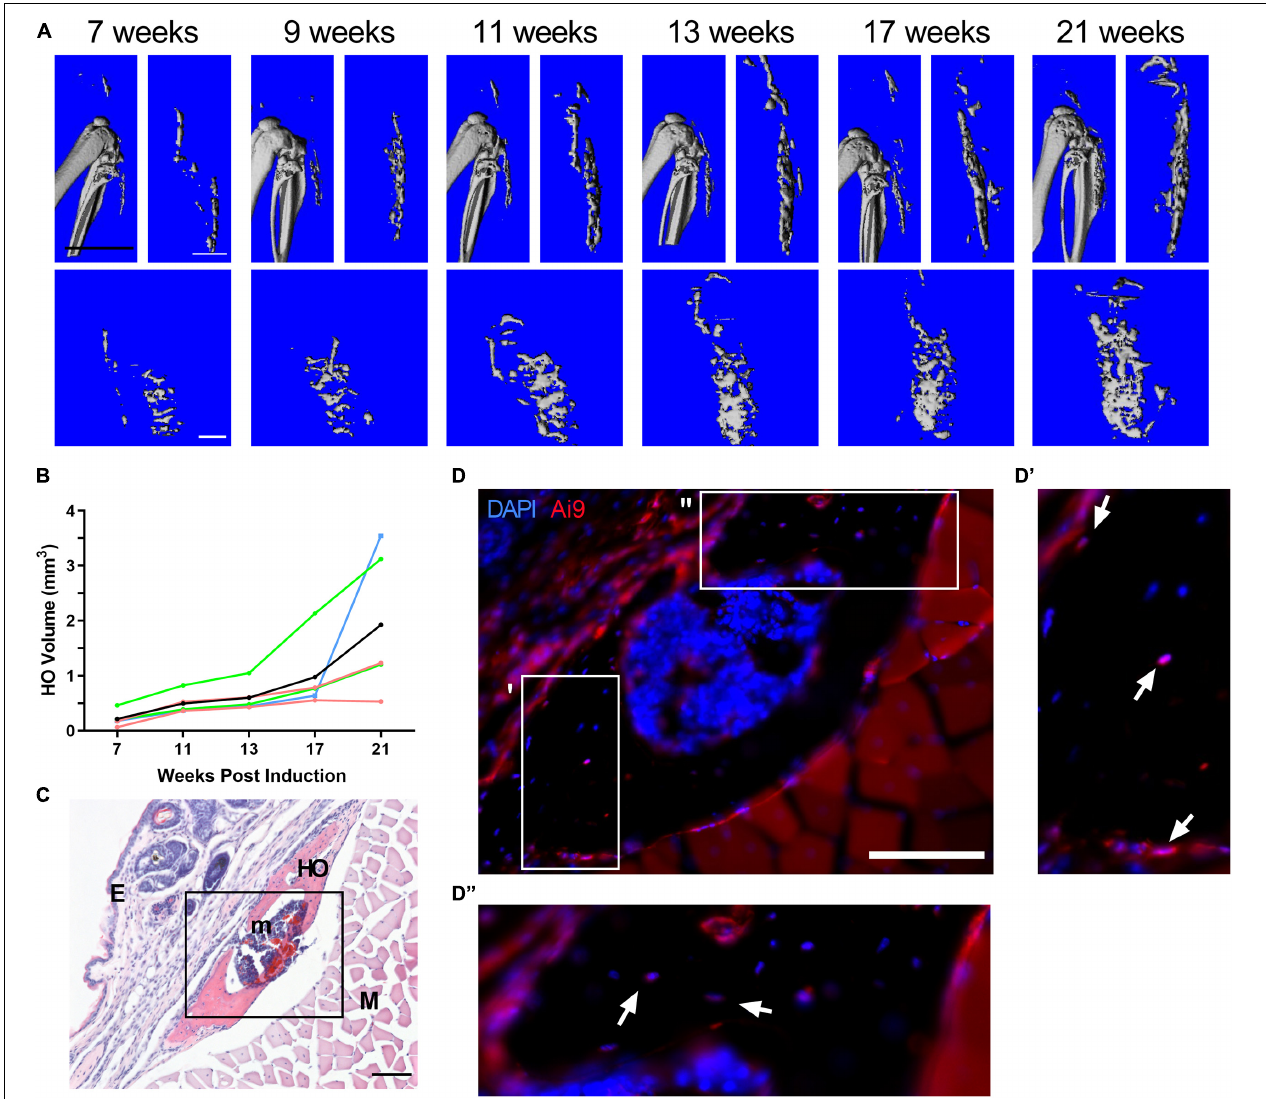
FIGURE 1 | Homozygous deletion of Gnas induces subcutaneous heterotopic ossification in vivo . R26-CreERT2;Gnas fl / fl ;Ai9 fl / + mice (at 4 weeks old) treated with local hindlimb injection of tamoxifen were examined for ectopic bone formation post- Gnas deletion. (A) Images of a representative series of longitudinal 3D in vivo µ CT scans at 7 through 21 weeks post-inactivation. Top – Sagittal view with and without skeletal bone. Bottom – Coronal view of ectopic bone. White scale bar = 1 mm, black scale bar = 5 mm. (B) Quantified volumes of HO ( n = 5); the volume of HO in each animal (raw data provided in Supplementary Table 1 ) was normalized to the HO volume detected at 7 weeks. Colors – individual mice, Black – average. (C) Representative histological section of subcutaneous HO at 21 weeks post-induction (H&E); scale bar = 100 µ m. HO, heterotopic ossification (mineralized bone); E, epidermis; m, bone marrow; and M, muscle. (D) Immunofluorescent imaging of HO region (box in panel C ) to detect Ai9 + ; Gnas -null cells; nuclei were co-stained with DAPI. Boxes in (D) indicate areas with multiple Ai9-negative cells within bone, shown at higher magnification in (D (cid:48) and D (cid:48)(cid:48) ) . Ai9 positive (arrows) and negative cells also appear along the bone surface. Scale bar = 100 µ